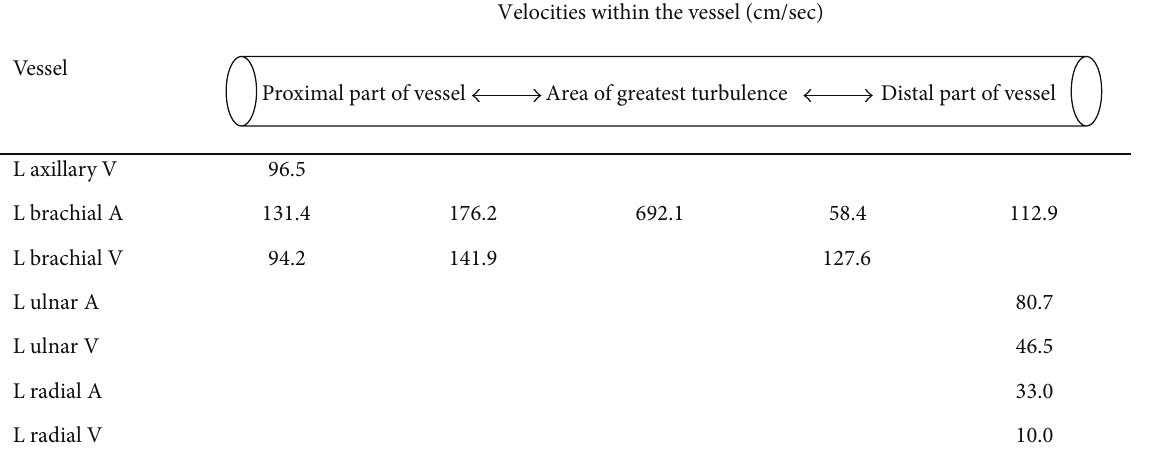
Figure 2: A representation of findings from the Doppler ultrasound of the left arm (L: left, V: vein, and A: artery).